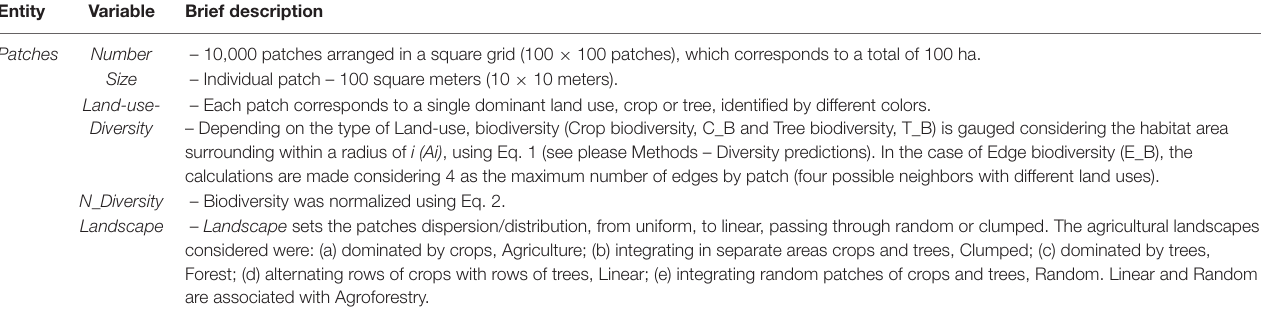
TABLE 1 | Description of the variables of each conceptual entity used in the model.